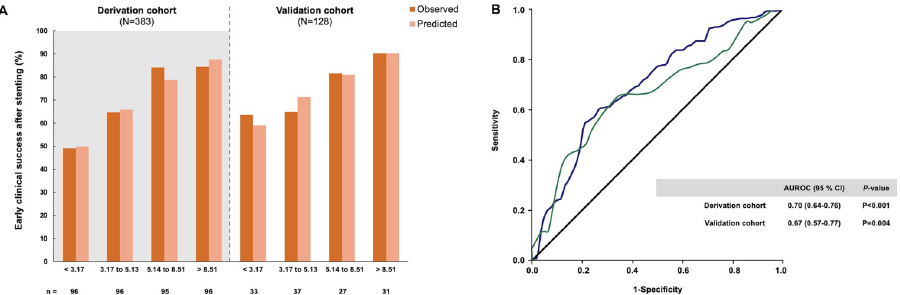
Fig 1. The probability of � 50% total bilirubin reduction within 2 weeks after endoscopic drainage and diagnostic accuracy of the risk score in the derivation and validation cohorts. (A) The observed and predicted clinical success rates are based on the approximate quartiles of the risk score. (B) The area under the receiver operating characteristic curve of the risk